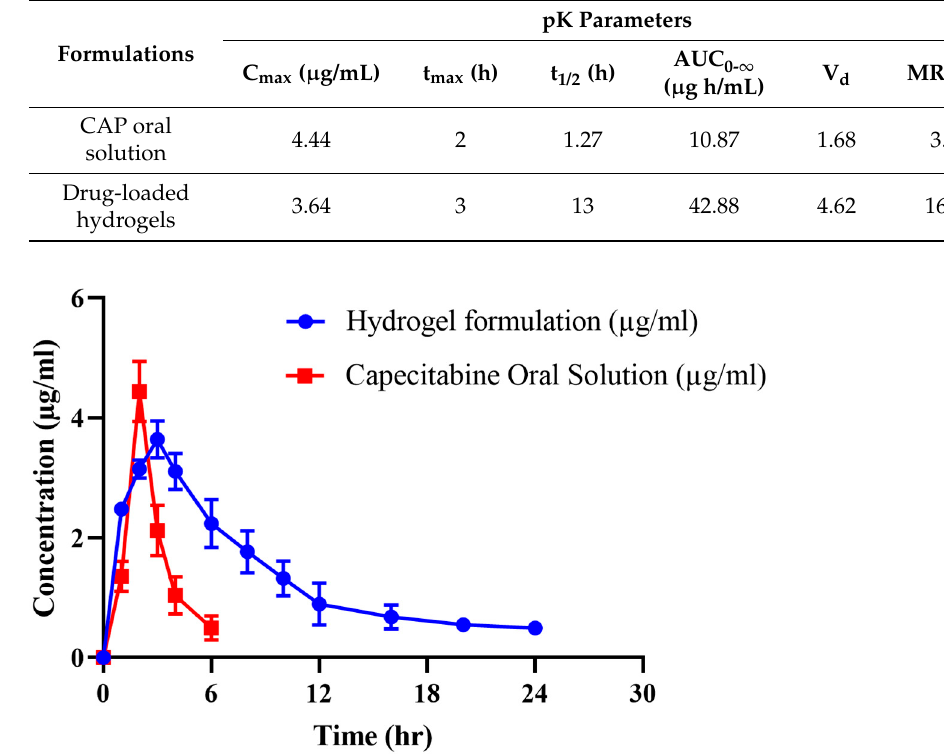
Figure 12. Plasma concentration vs. time profile of CAP after administration of oral solution and hydrogels. Table 6. Pharmacokinetic parameters of pure drug and drug ‐ loaded polymeric network.